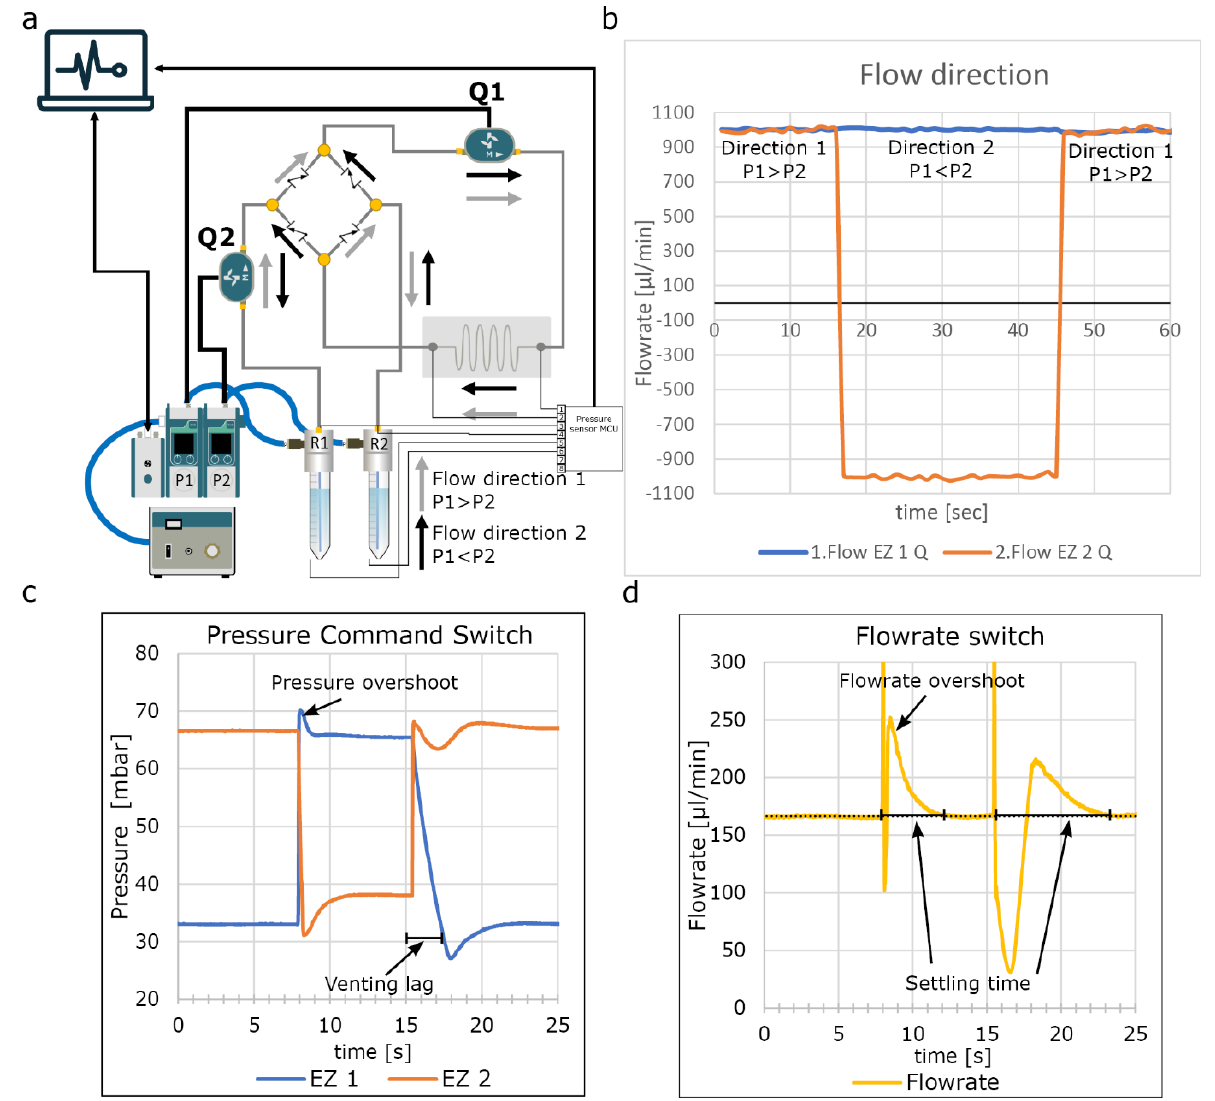
Figure 4. Graetz recirculation circuit. ( a ) Schematic of the fluidic circuit used shows the microfluidic analogy of the Graetz bridge used in an AC/DC convertor using check valves; if the pressure in R1 is higher than R2, fluidic flow follows the gray arrows. When the pressure is reversed, fluidic flow follows the black arrows, remaining unidirectional at Q1 and bidirectional a Q2. ( b ) Direct measurement of the recirculation. When pressure commands are reversed, the flow is reversed at flow rate sensor Q2, however, remains unidirectional at flow rate sensor Q1. ( c ) High resolution recording of the pressure switch at the fluidic reservoirs shows small overshoot and undershoot in pressure resulting in spike in flow rate. Interestingly EZ1 vents slower than EZ2 affecting the algorithm. ( d ) Measured flow rate shows the overshoot due to the pressure overshoot and settling time of approximately 4 s, due to the venting lag of EZ1 settling time is approximately 8 s. See video S1 to see perfusion of suspended micro beads during switching.